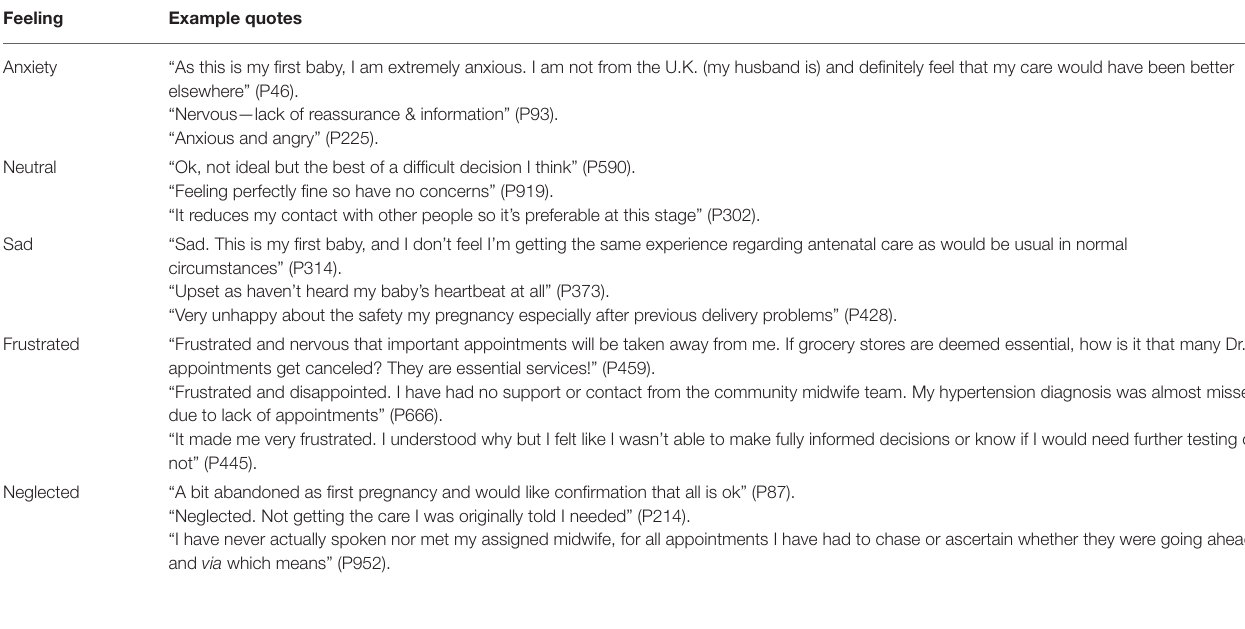
TABLE 3 | Example responses when participants were asked how they felt about services being